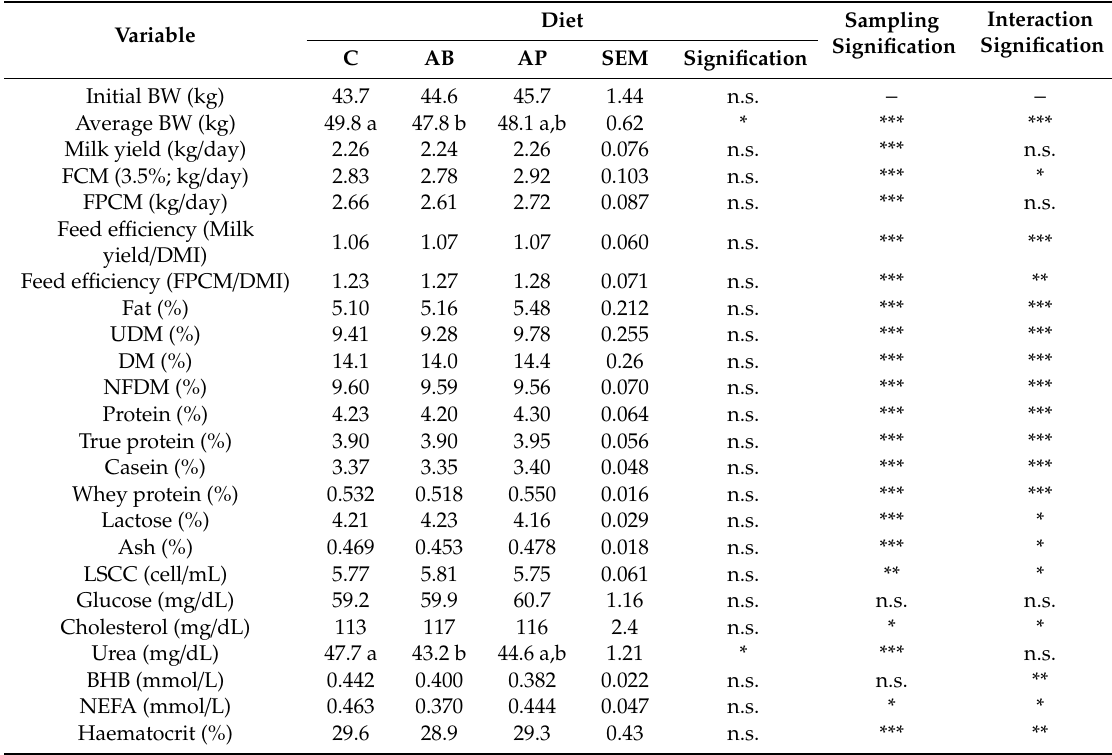
Table 2. Results of the comparison of means of the variables related to body weight, food intake, milk yield and composition, somatic cell count and basal metabolism, according to the e ff ects considered in Experiment